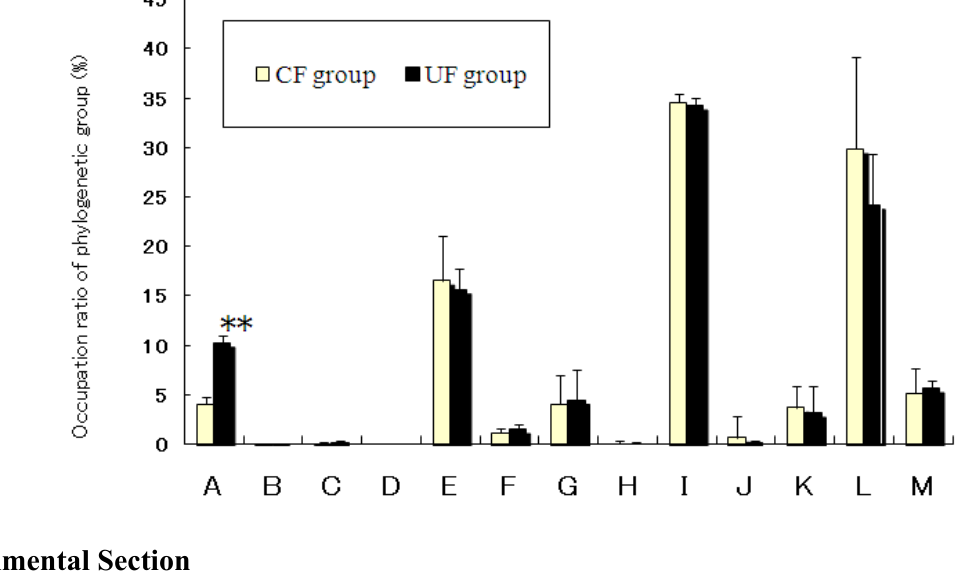
Figure 4. Composition of cecal intestinal microflora of mice in the ume fiber (UF) and cellulose (CF) groups. OTUs (operational taxonomic units), which correspond to either T-RFs (terminal restriction fragments) or T-RF clusters, detected by T-RFLP analysis. Values are means ± SE (n = 7). **Significantly different (p < 0.01) from the CF group.